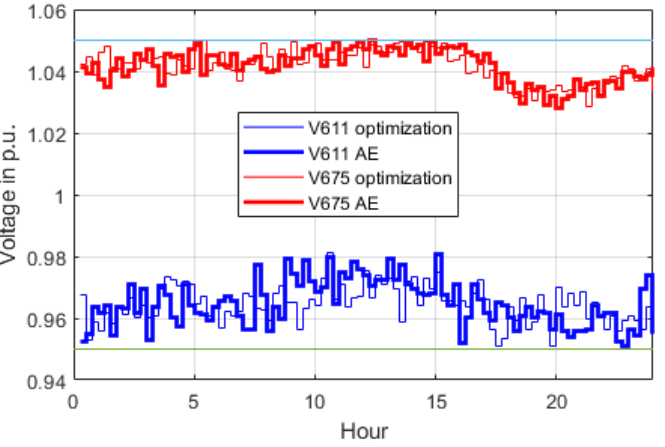
Figure 9. Rewards and average rewards of QL and AE.